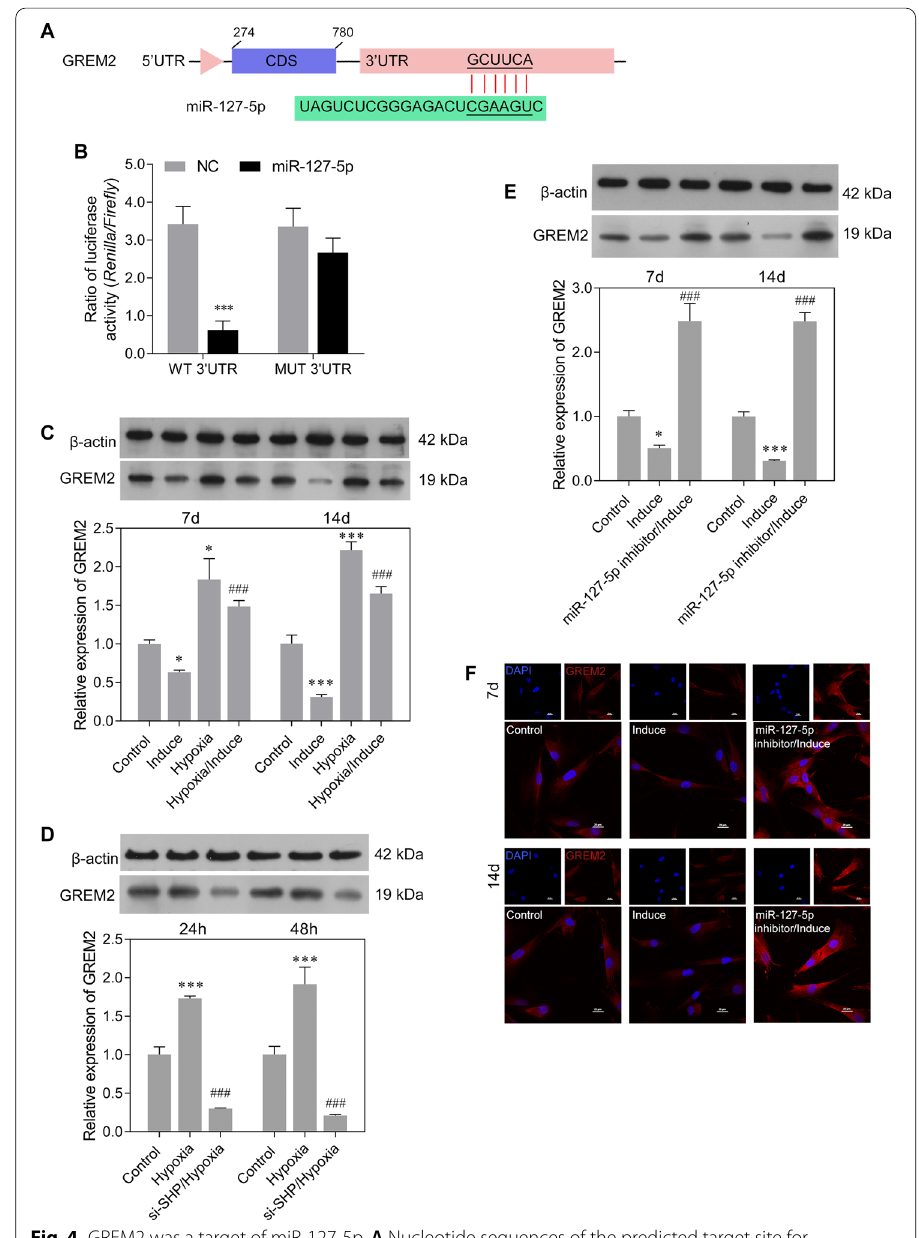
Fig. 4 GREM2 was a target of miR-127-5p. A Nucleotide sequences of the predicted target site for miR-127-5p in the GREM2 3 ʹ -UTR. B Luciferase reporter assays were performed to identify direct interaction between miR-127-5p and the GREM2 3 ʹ -UTR. Wild type and mutant miR-127-5p target binding sequences in the GREM2 3 ʹ -UTR were cloned into a reporter luciferase vector and co-transfected with the synthetized miR-127-5p (or NC) into rMSCs. *** p < 0.001, compared with NC; C GREM2 protein expression was measured in rMSCs from the control, induction, hypoxia, and hypoxia/induction groups. D GREM2 protein expression was measured in rMSCs from the control, induction, and si-SHP/hypoxia groups. E GREM2 protein expression was measured in rMSCs from the control, induction, and miR-127-5p inhibitor/induction groups. F GREM2 protein expression in rMSCs was measured by immunofluorescence. * p < 0.05, *** p < 0.001, compared with control; # p < 0.05, ### p < 0.001, compared with hypoxia or induction